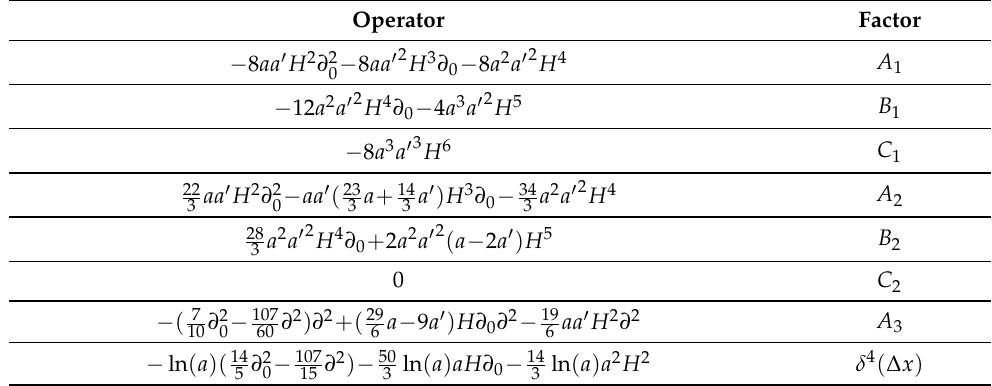
Table 15. Contributions for 2 iT 7 + 3 iT 8 + iT 12 + iT 17 . Each tabulated term must be multiplied by κ 2